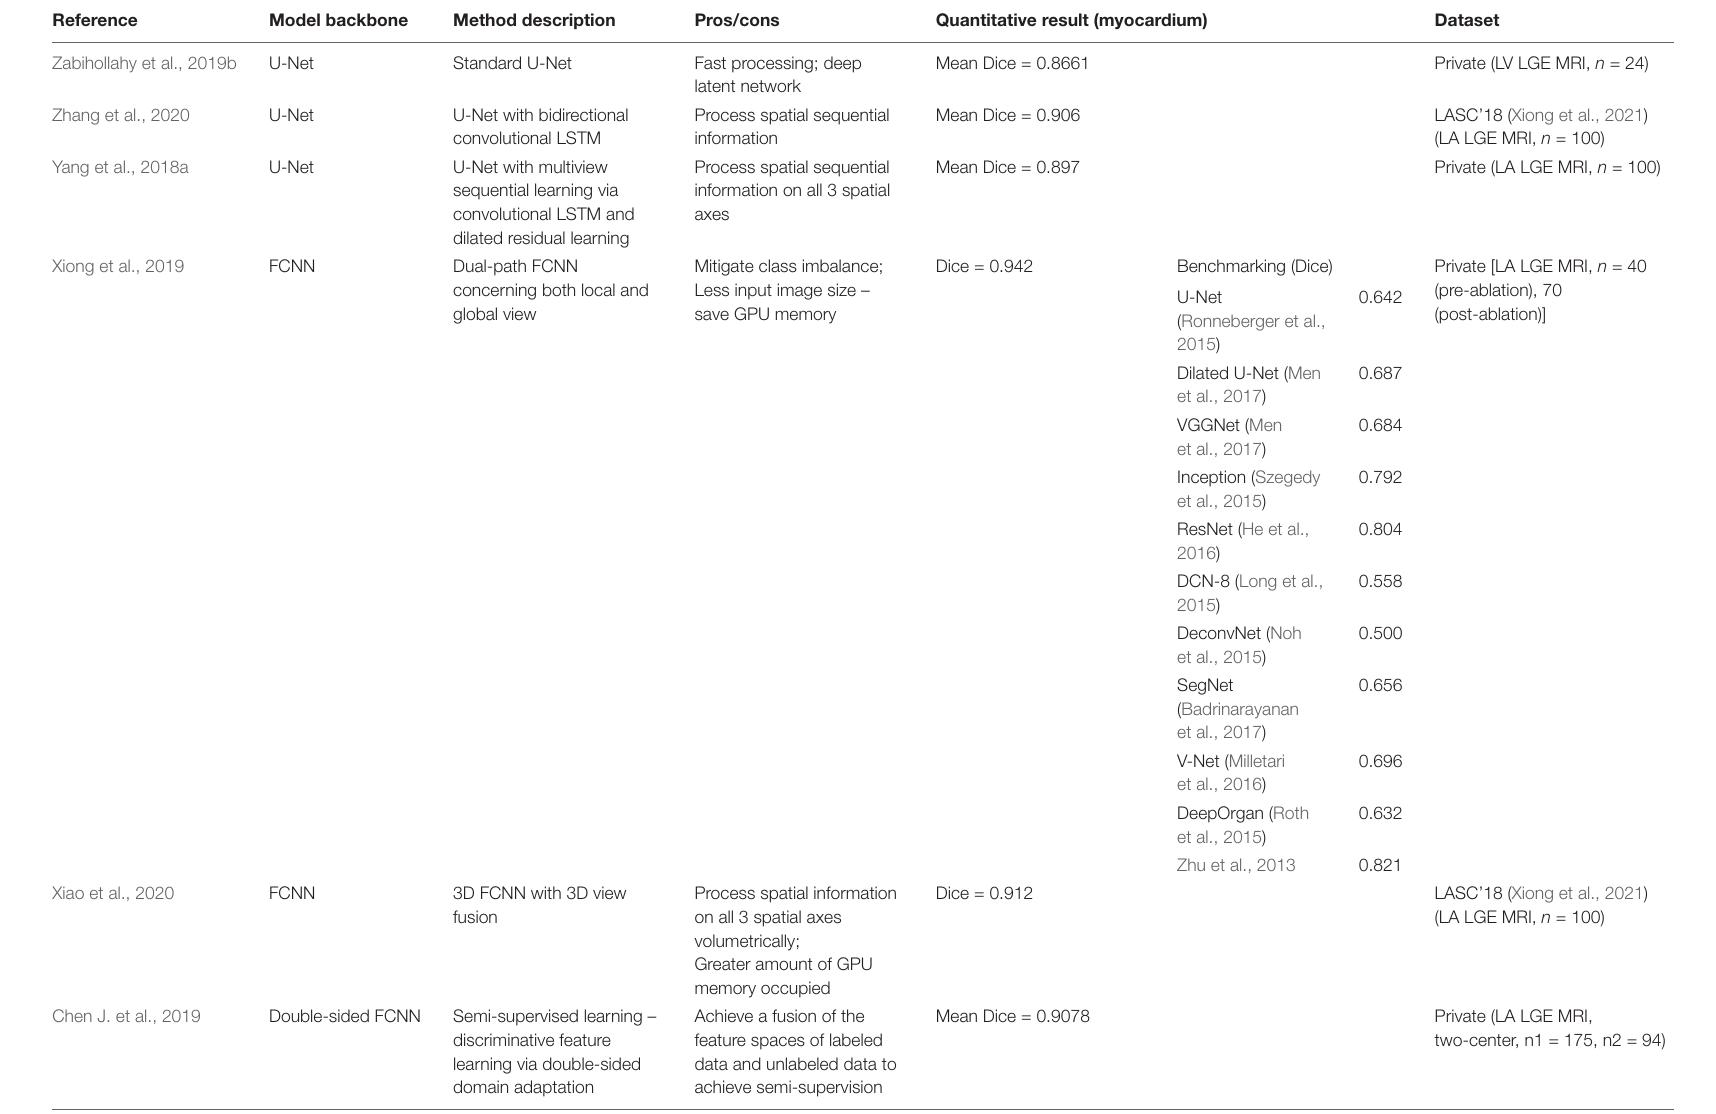
TABLE 4 | Summary of representative deep learning based methodologies for segmentation of the myocardium on